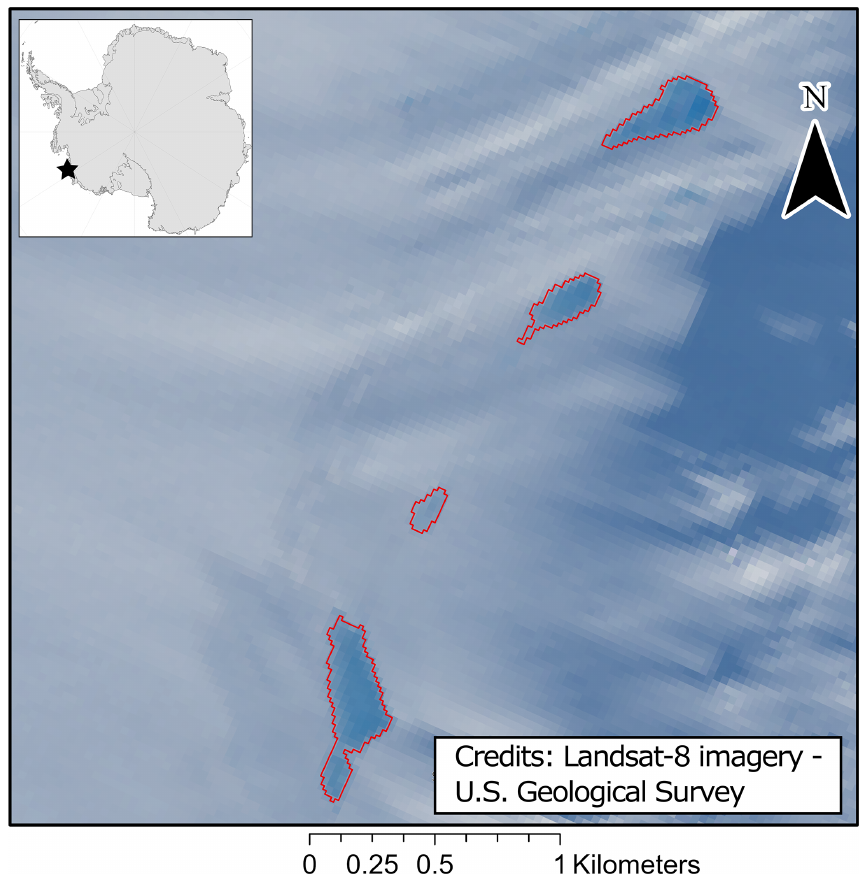
Figure 5. Lakes identified for the first time in the western Amundsen Sea sector of West Antarctica, with the largest, southernmost lake of the four crossing the grounding line of the Getz Ice Shelf. The image is a true colour composite of L8 satellite imagery, tile LC08_L1GT_166131_20170112 from 12 January 2017. The red outlines are the lake polygons resulting from our NDWI threshold ap- proach. Inset: Getz IS and lake locations in Antarctica. Imagery was accessed from US Geological Survey, http://earthexplorer.usgs.gov (last access: 3 December